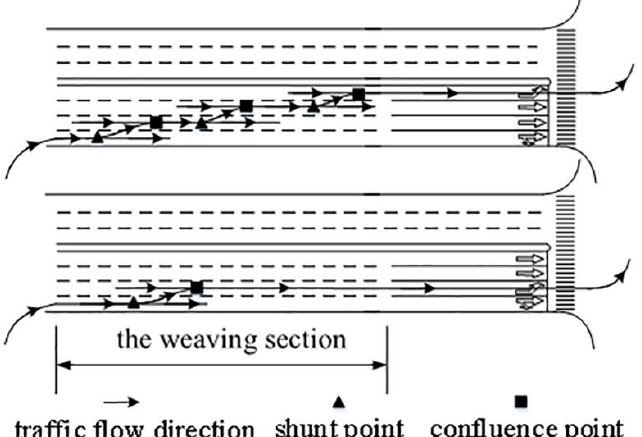
Figure 4. The weaving of traffic flow in inside and outside left-turn lanes.